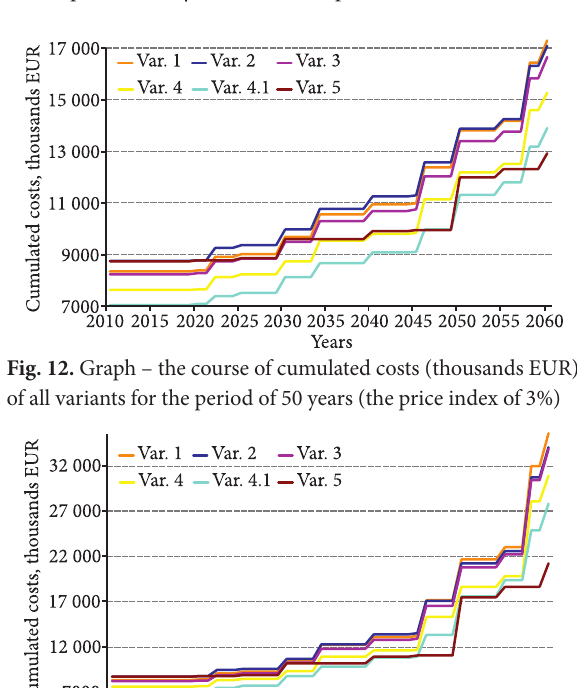
Fig. 11. Graph – cumulated costs (thousands EUR) of all variants for the period of 50 years (in current prices)